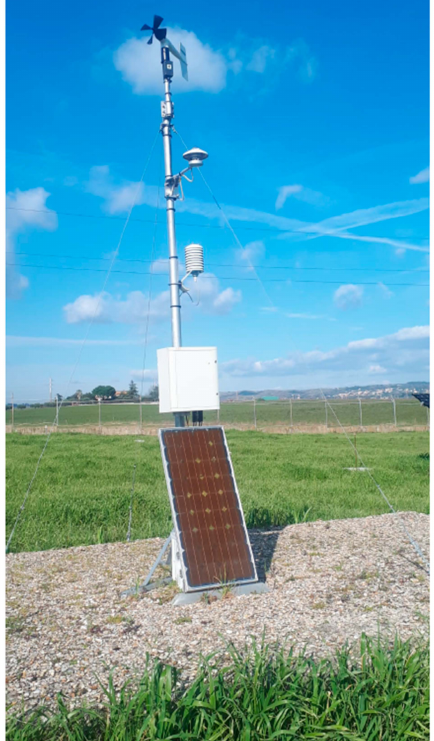
Figure 4. SMART metering system of PV